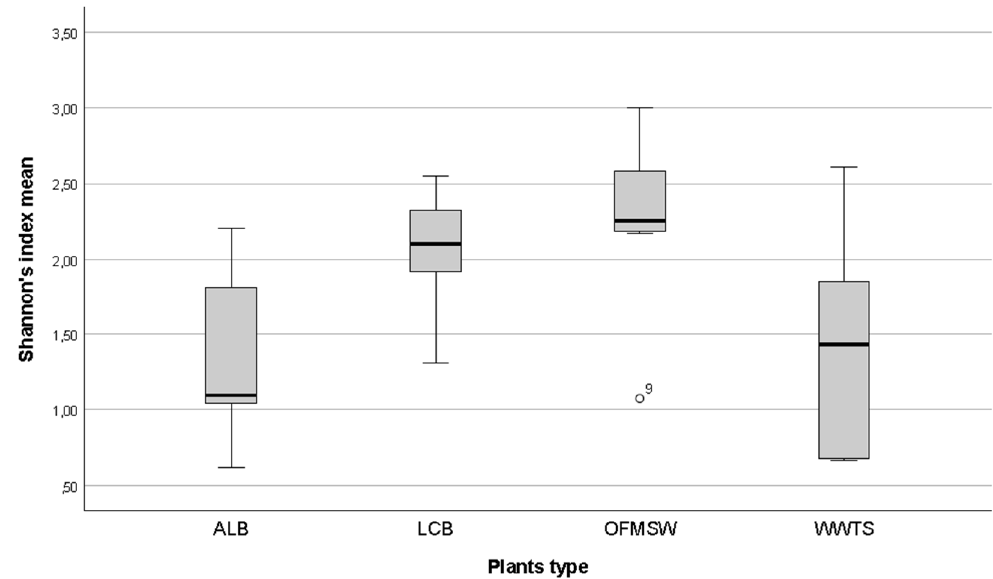
Figure 3. Boxplot of biodiversity Shannon’s indices in relation to the type of plant investigated.